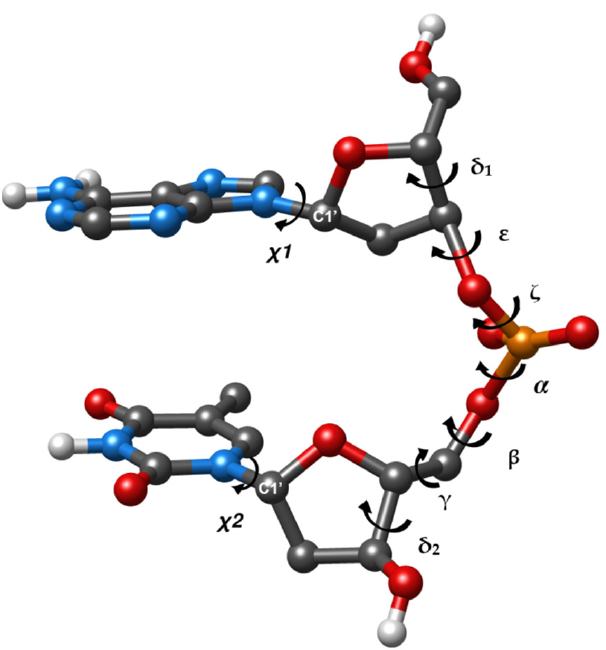
Figure 1. Designation of torsion angles in dDMPs in the example of dApdT.